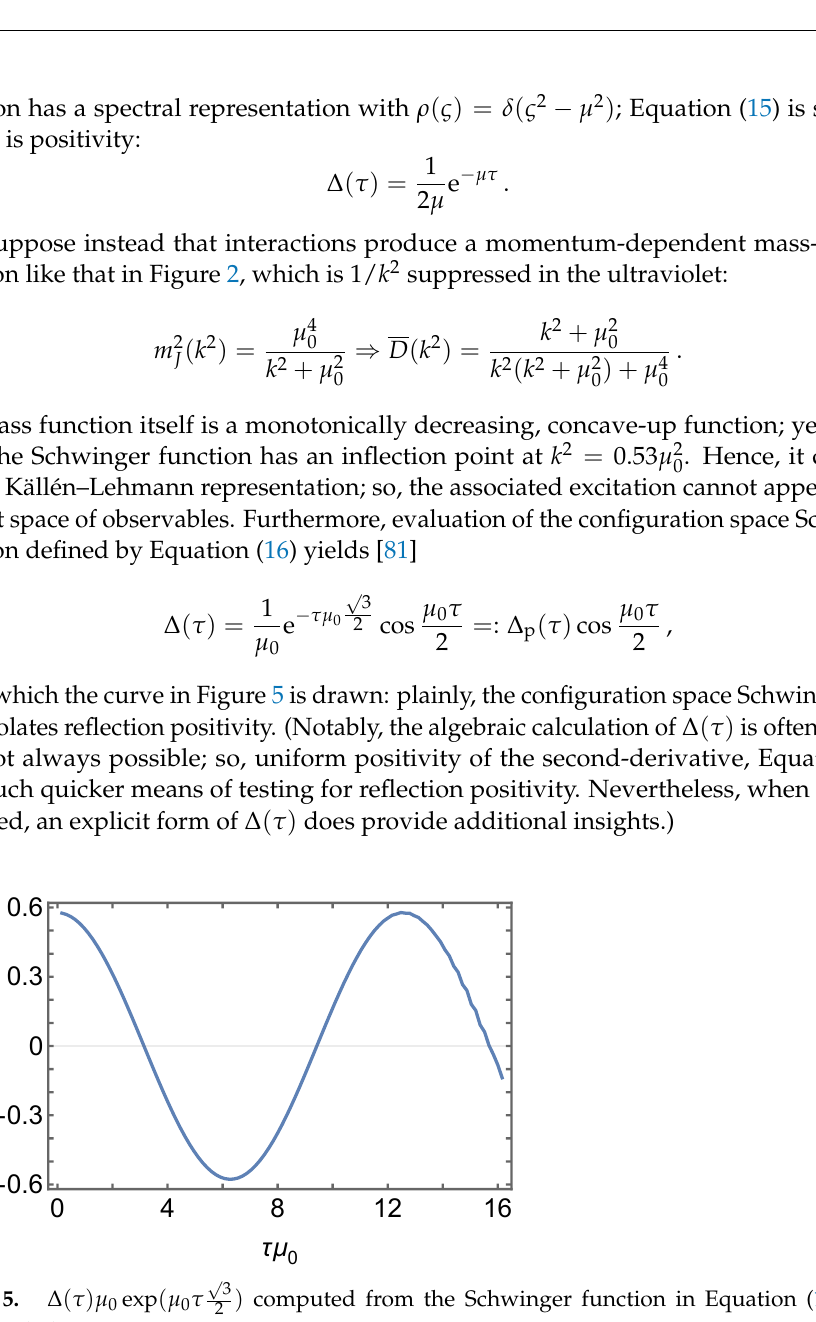
Figure 5. ∆ ( τ ) µ 0 exp ( µ 0 τ Equation